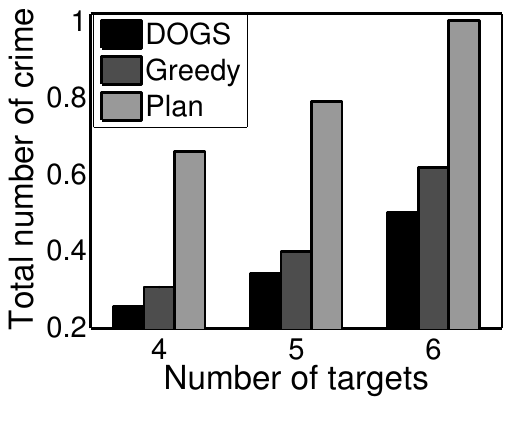
Figure 7. Varying N